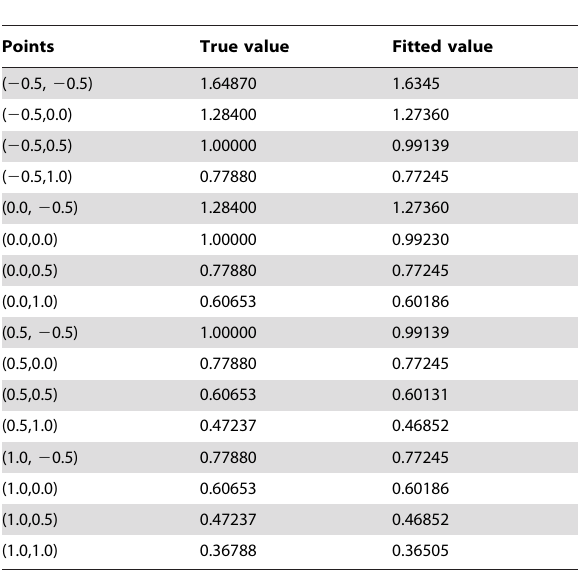
Figure 2. The original plot of the variance function.